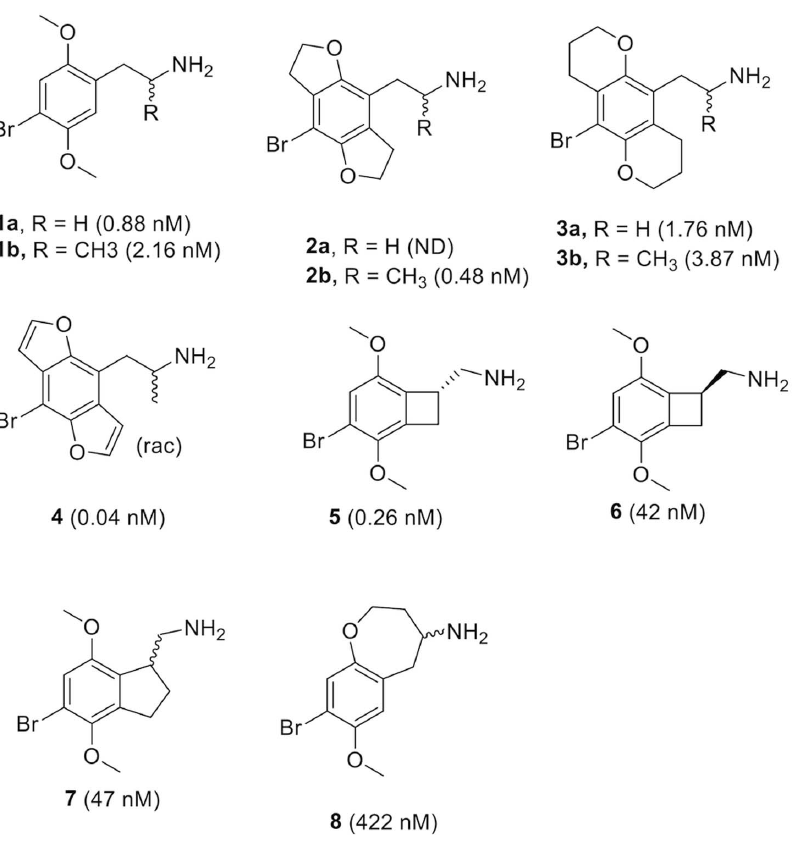
Figure 1. Published conformationally restrained analogs of 1. 5-HT 2A affinities are given within parenthesis.